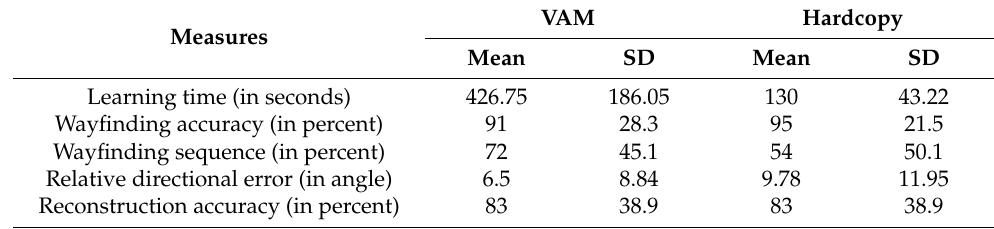
Table 3. Mean and standard deviation for tested measures as a function of learning-mode conditions.